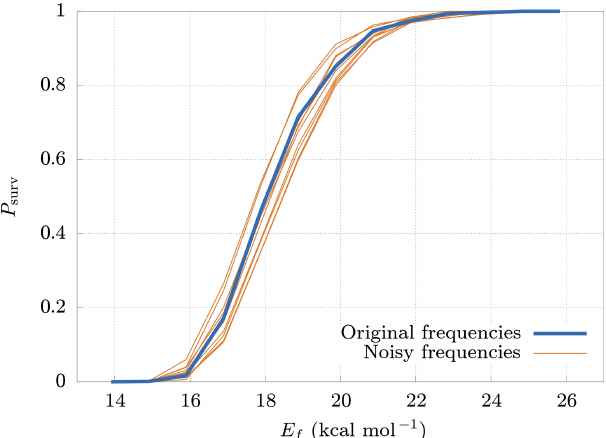
Figure 7. Deviations (thin lines) from original survival probability P surv (thick line) for 10 different sets of random input frequencies (noisy frequencies), obtained adding random noise to the original frequencies. The new sets of frequencies have been drawn from nor- mal distributions having the original frequency as mean and with a standard deviation equal to 20% of their mean. The results are rel- )( H 2 SO 4 )( HOM 10 ) cluster. ative to the ( HSO − 4